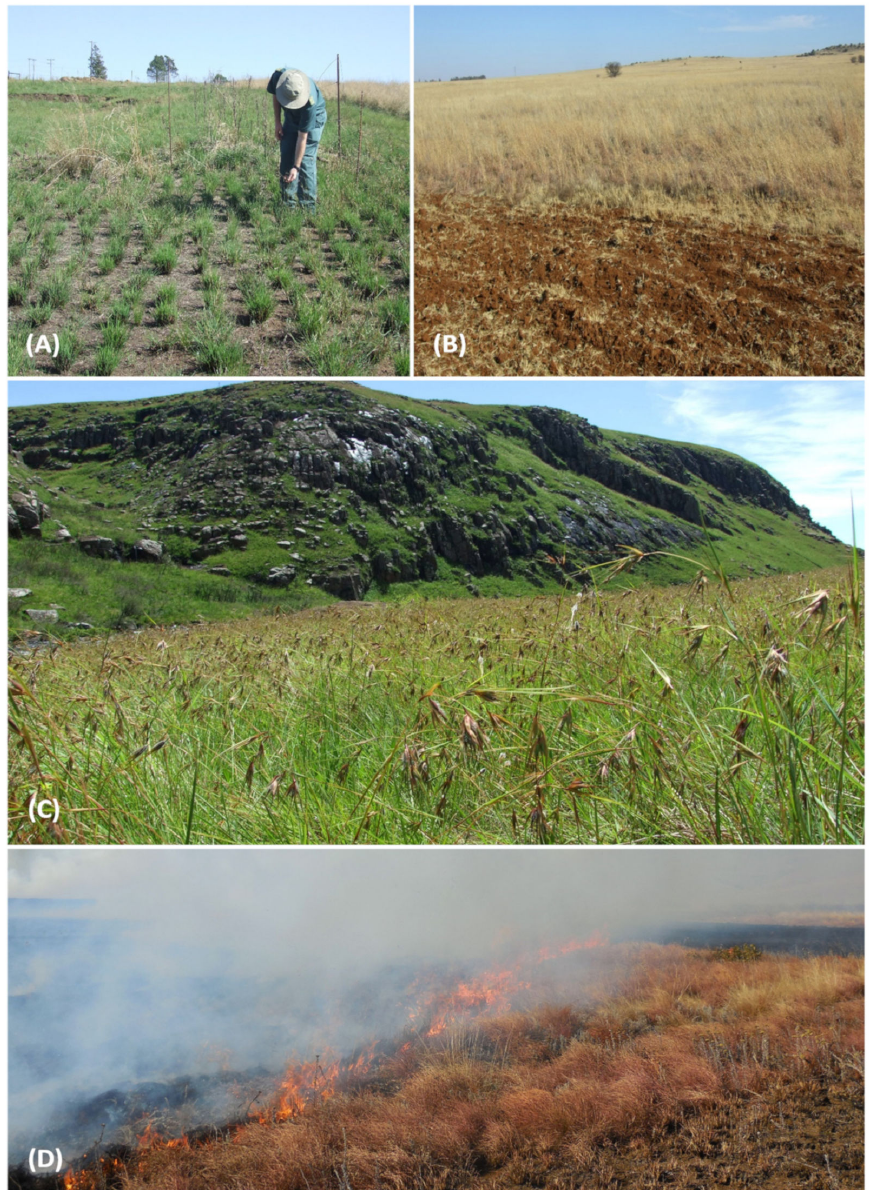
Figure 4. Assisted natural regeneration: ( A ) Themeda triandra Forssk., a popular choice for grassland restoration, particularly from vegetatively propagated tufted plugs (4 October 2013); ( B ) a ripped experimental soil surface prepared for reseeding (23 July 2014); ( C ) T. triandra , a keystone grass species associated with high biodiversity and high rangeland value grasslands in South Africa (23 November 2012); ( D ) fire is a key ecological driver and restoration management tool in South Africa’s frost-cured pyrogenic grasslands (11 June 2019). All photos by C. Carbutt except Figure 4A, credited to J. Longmore and used with